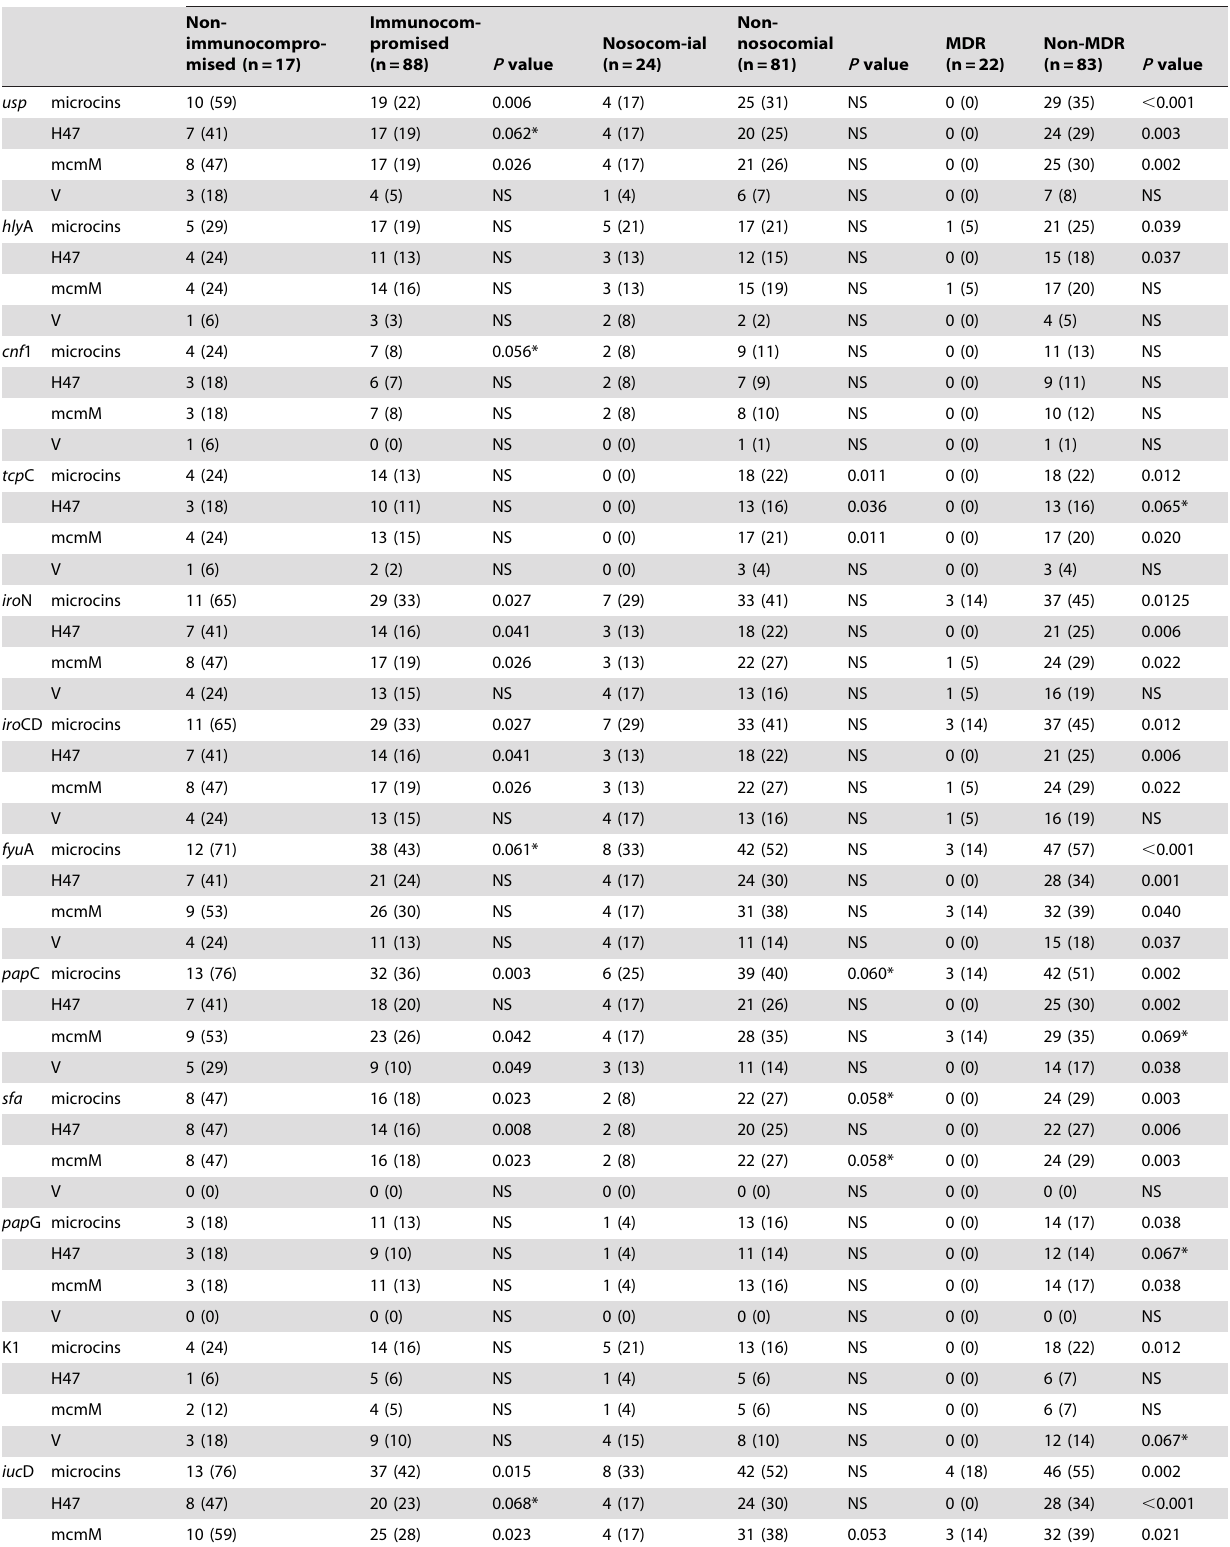
Table 2. Significant co-associations of virulence factors and microcins in relation to host characteristics and drug resistance.